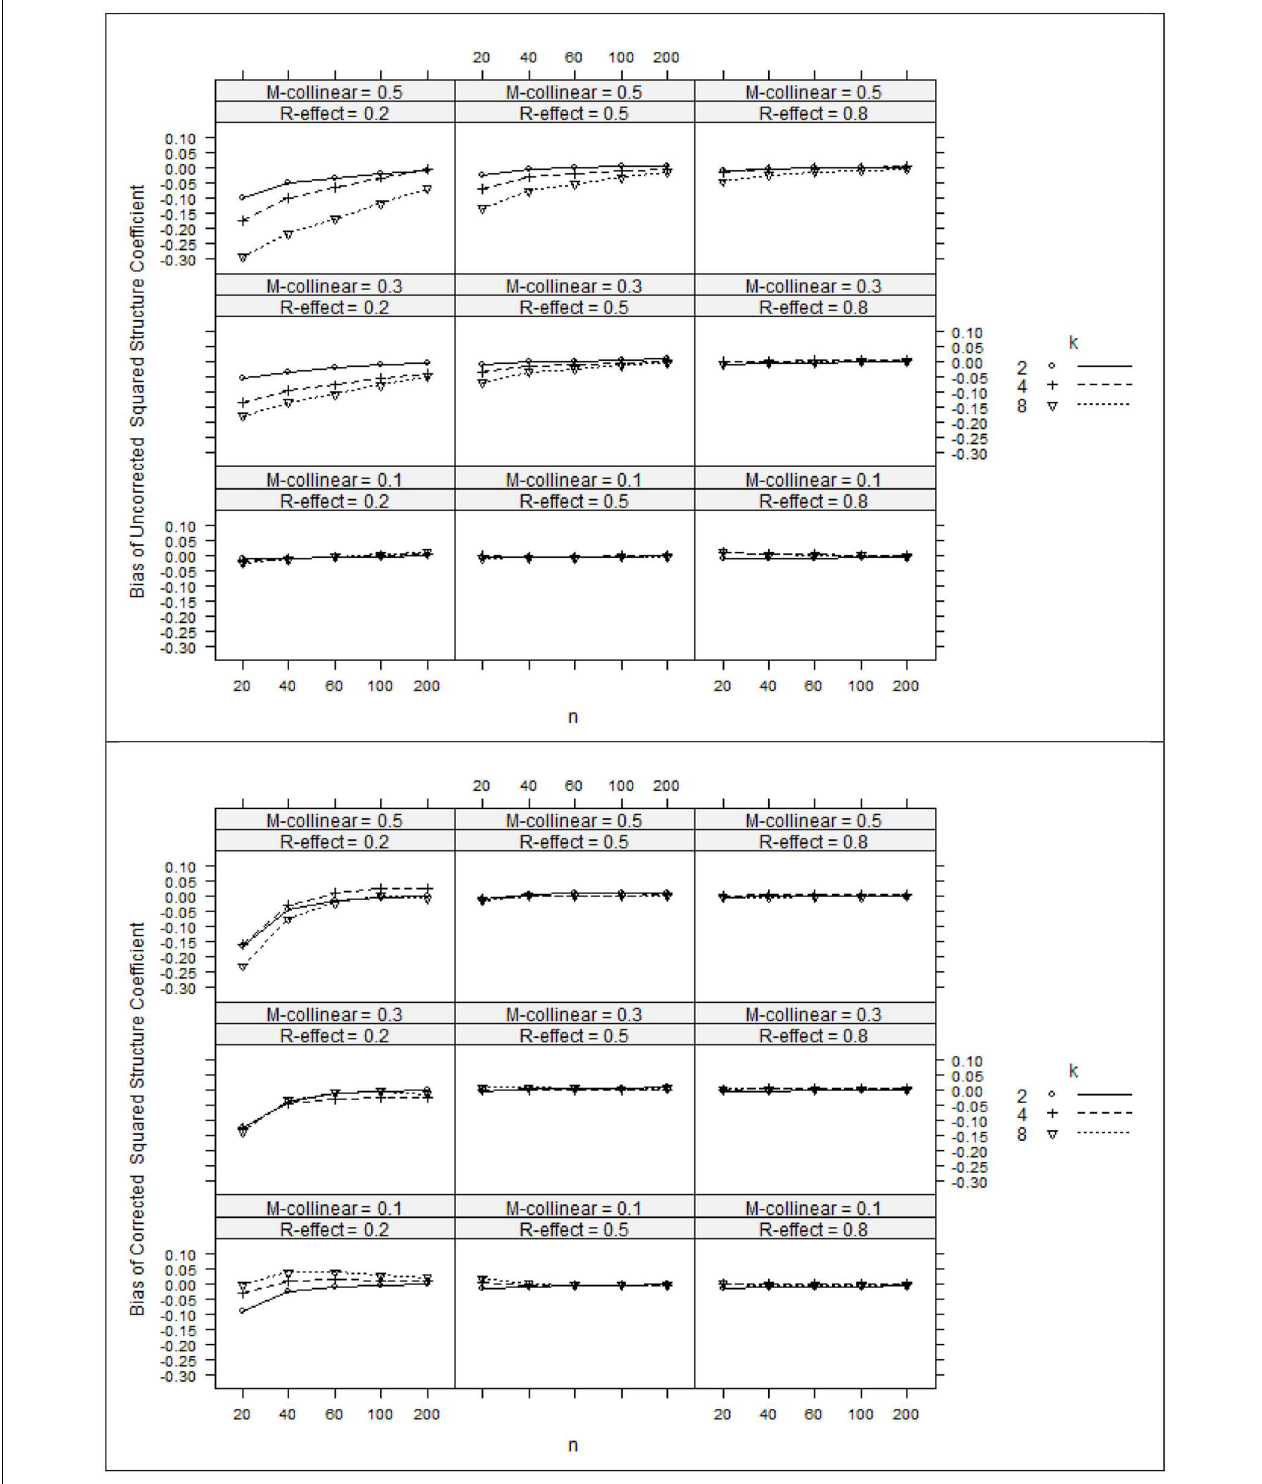
FIGURE 1 | Bias of uncorrected squared structure coefficients (top panel) and corrected squared structure coefficients (bottom panel). k , number of predictors; n , sample size.